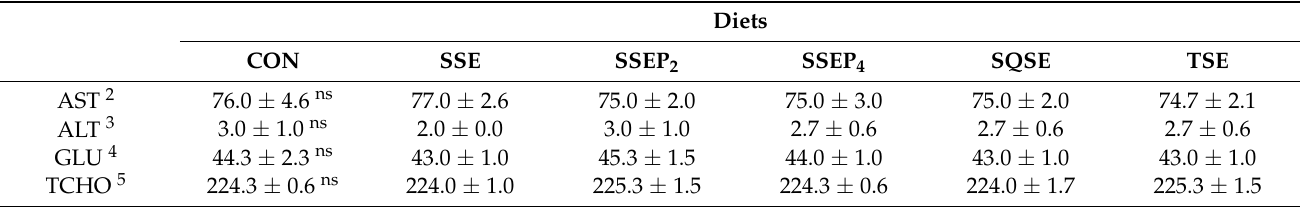
Table 4. Hematological parameters of Nile tilapia fed six experimental diets for eight weeks 1 .